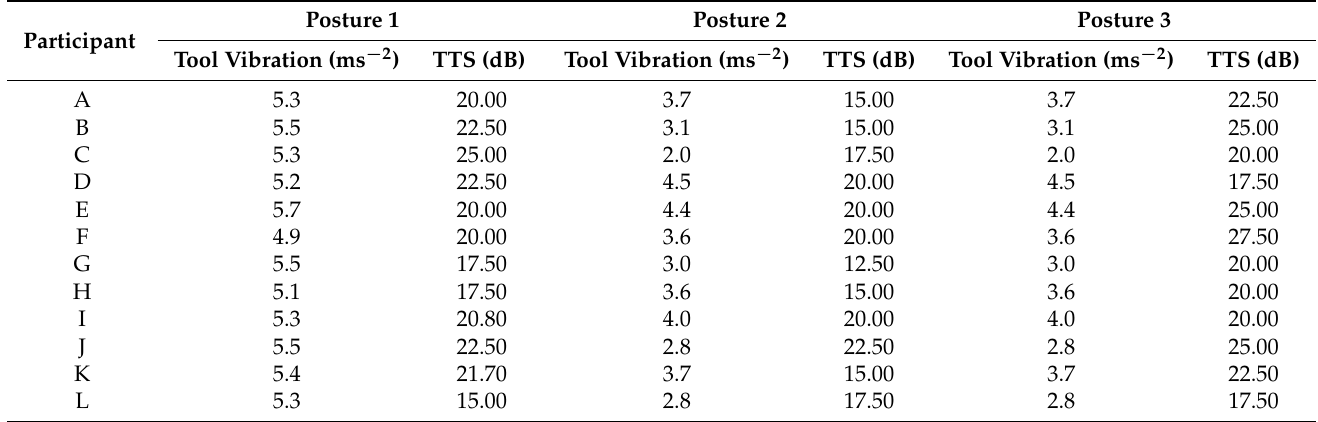
Table 1. Test results summary (all participants).